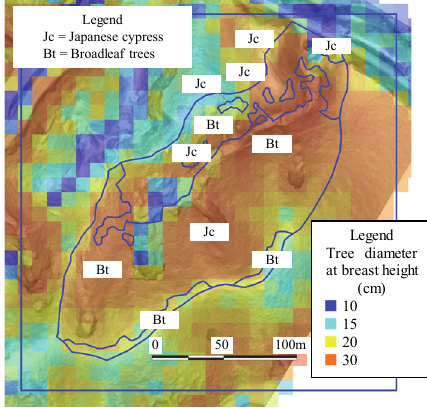
Figure 6. The diameter at breast height ( D ) in the watershed